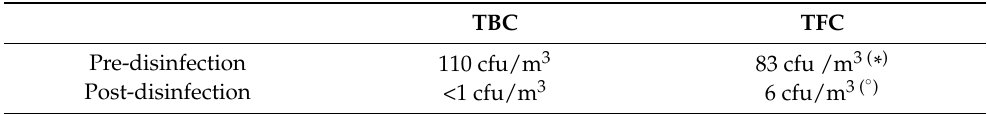
Table 1. Airborne Total Bacterial Count (TBC) and Total Fungal Count (TFC) pre-/post-disinfection by hydrogen peroxide (5%) and ethyl alcohol